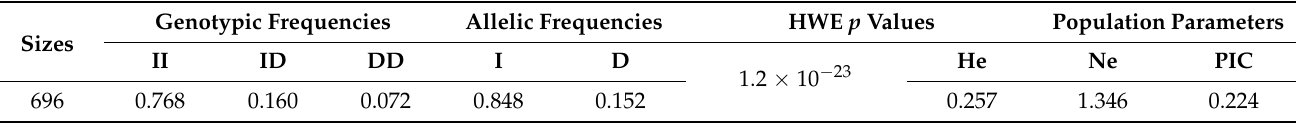
Table 2. Polymorphism parameters of P1-D 13-bp of bovine ITG β 5 gene.